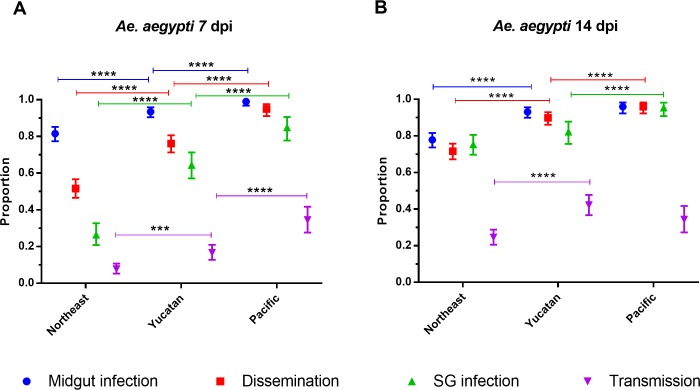
Midgut infection, dissemination, salivary gland infection and transmission rates of Ae. aegypti by region.A) rates at 7 dpi and B) 14 dpi. Error bars represent 95% confidence intervals. Statistical significance is depicted as **** for p <0.0001, *** p<0.001, **p<0.01 and * p<0.05 by two-tailed Fisher’s exact test.